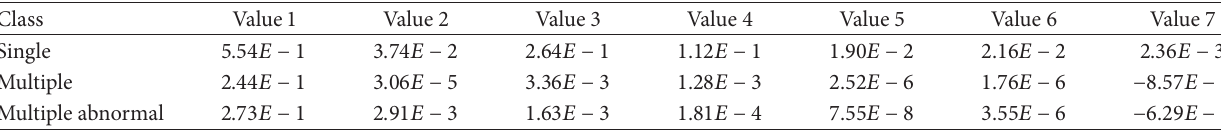
Table 3: Distinct values of Hu moments under different activities in Figure 9.